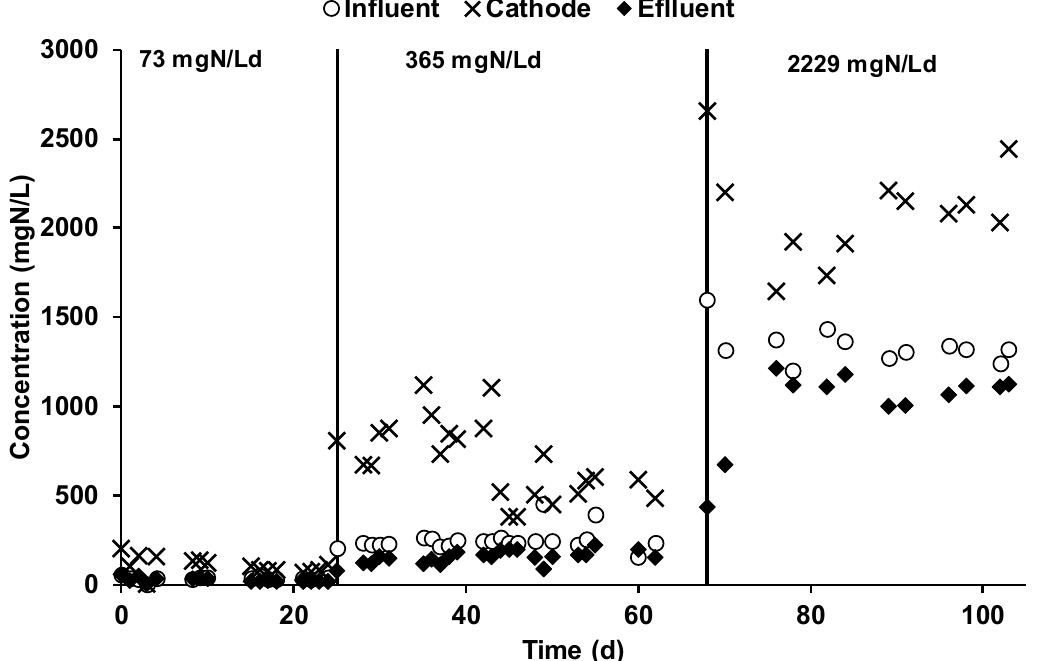
Figure 5. Ammonium concentration inside the chambers and the inlet of the anodic chamber.